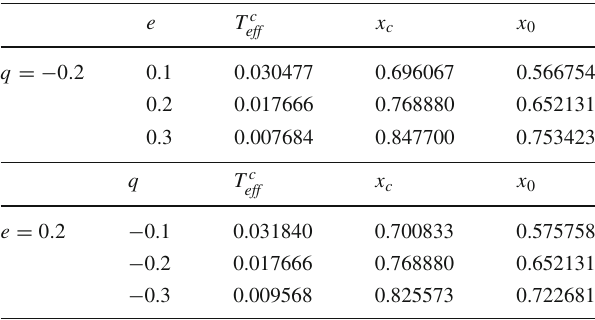
Table 1 Summary of the highest effective temperature T c corresponding x for different curves in Fig.